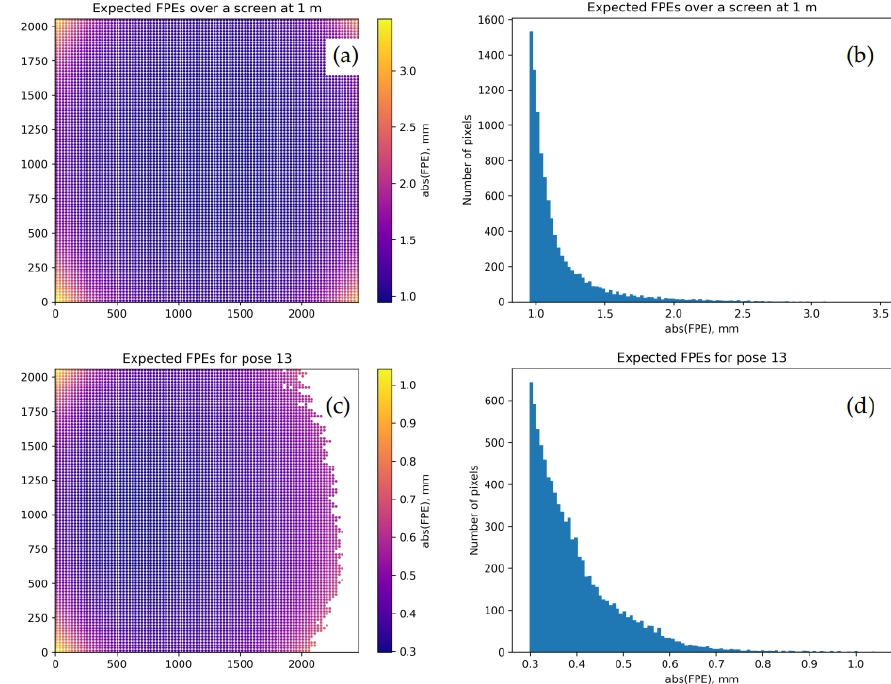
Figure 8. Uncertainty in view ray positions induced by the residual uncertainty in the intrinsic camera parameters as estimated by K-fold cross-validation. Model A is calibrated over the training subset Q train of the dataset 0; x- and y-axes in ( a , c ) are camera pixel coordinates. ( a , b ): map and histogram of EFPEGs (expected FPEs over the plane 1 m away from the camera). ( c , d ): map and histogram of EFPEs for the same pose as in Figure 5. As could be expected, EFPEs in ( a , c ) are bounded from below by a positive value that is achieved near the center of the